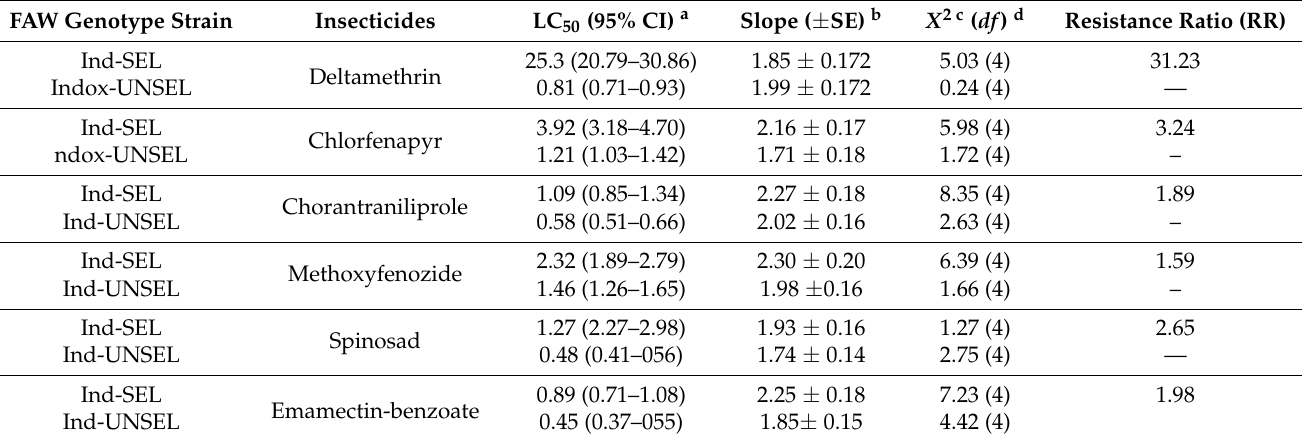
Table 3. Susceptibility and cross-resistance of Ind-SEL and Ind-SEL genotypes of S. frugiperda to different insecticides.